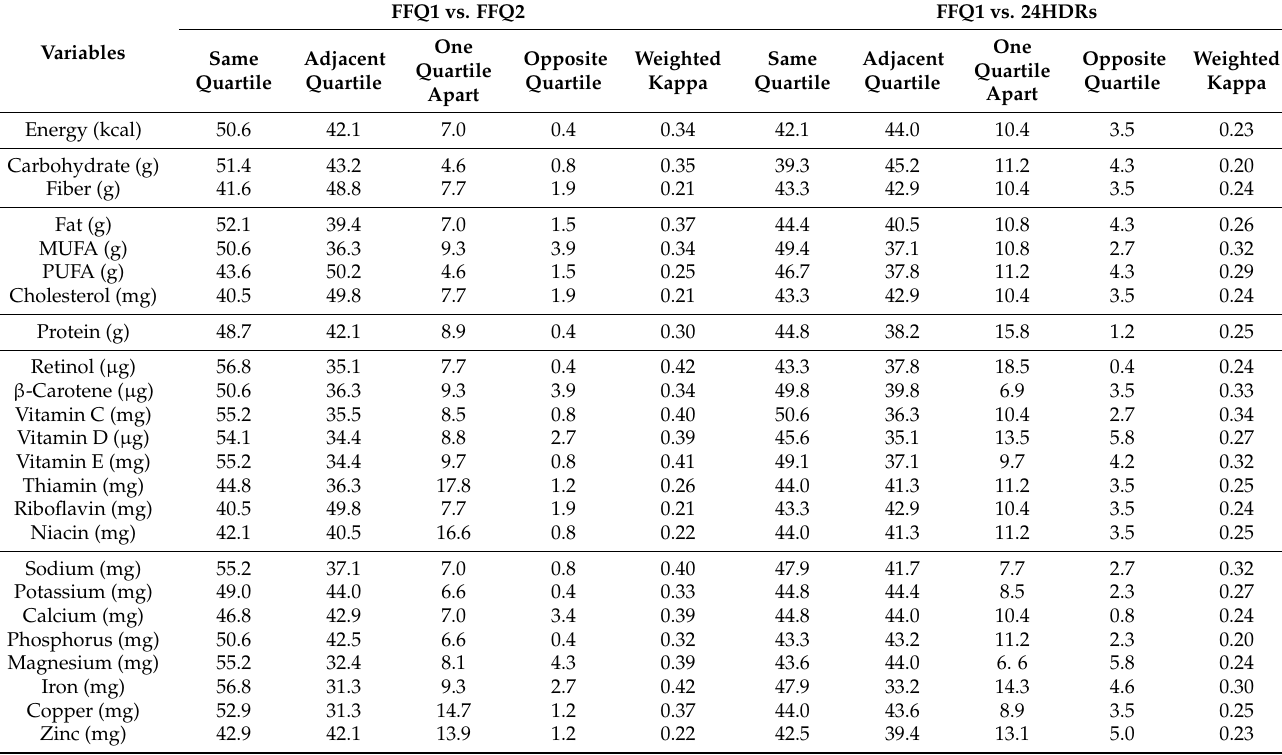
Table 5. Agreement rates (%) for the same quartile or adjacent quartile classifications, disagreement rates (%) for one quartile apart or opposite quartile classifications and weighted kappa values between FFQ1 and FFQ2 and between FFQ1 and the mean of